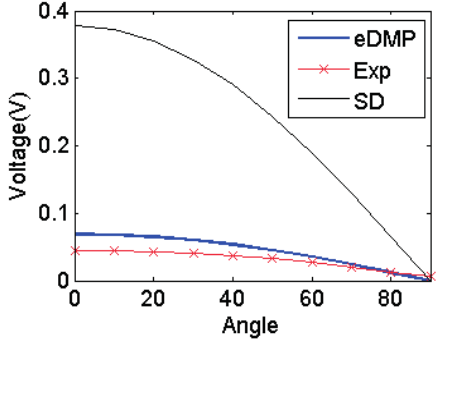
Figure 16. Simulation results